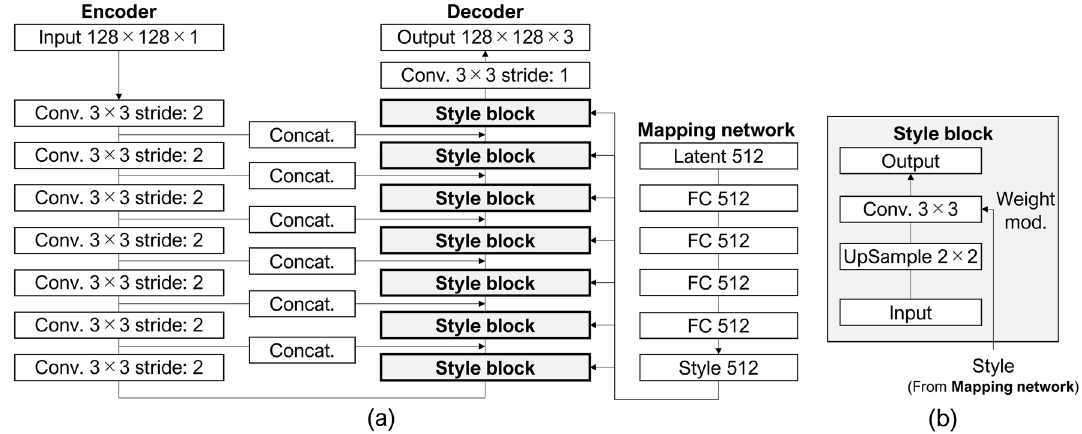
Figure 4. Network architecture of StylePix2pix. ( a ) Generator with style blocks and mapping network. ( b ) Structure inside the style